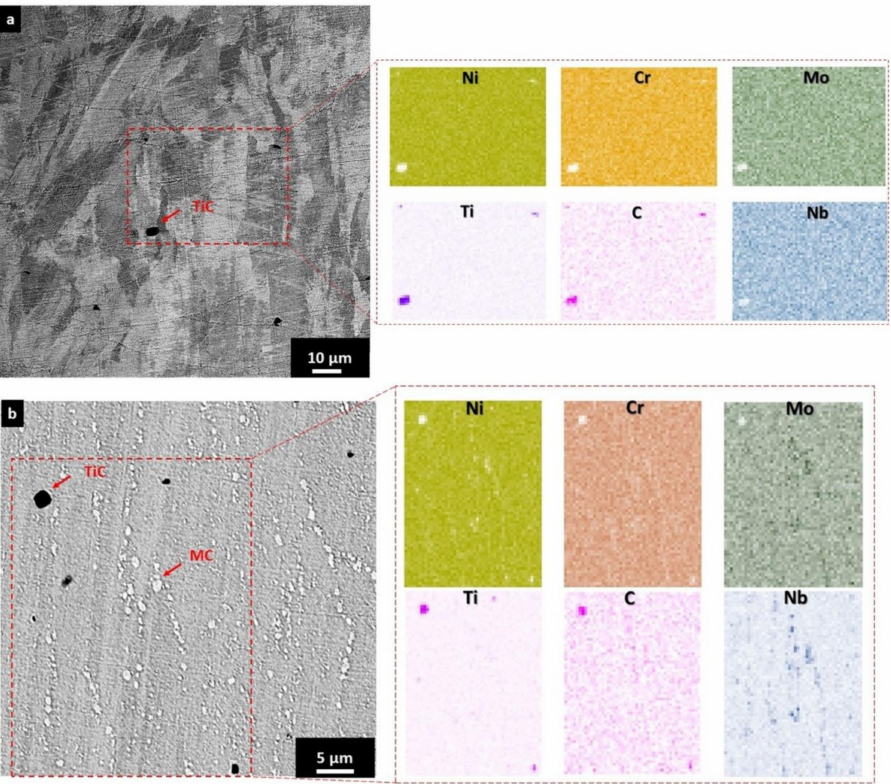
Figure 5. EDS maps of the ( a ) AB IN625/TiC and ( b ) SOL IN625/TiC states.